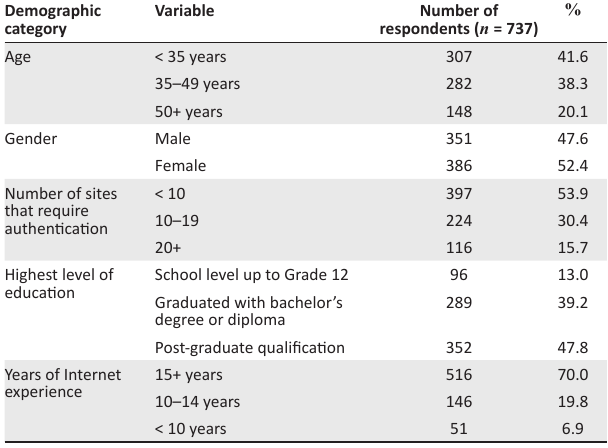
TABLE 2: Demographic composition of